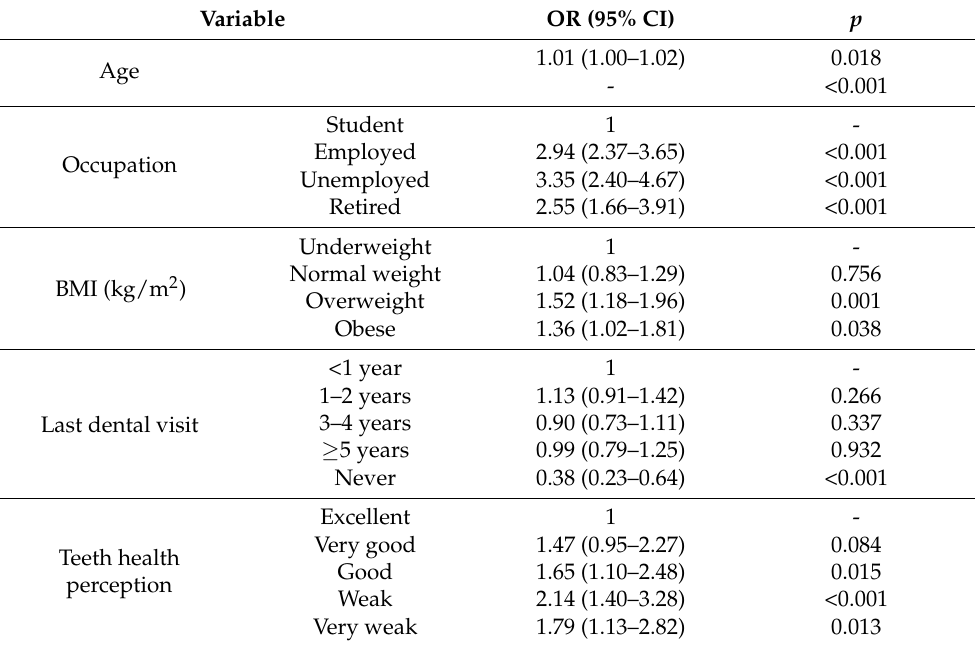
Table 5. Multivariate logistic regression analysis (final reduced model *) towards the outcome variable ‘caries presence’ (n =